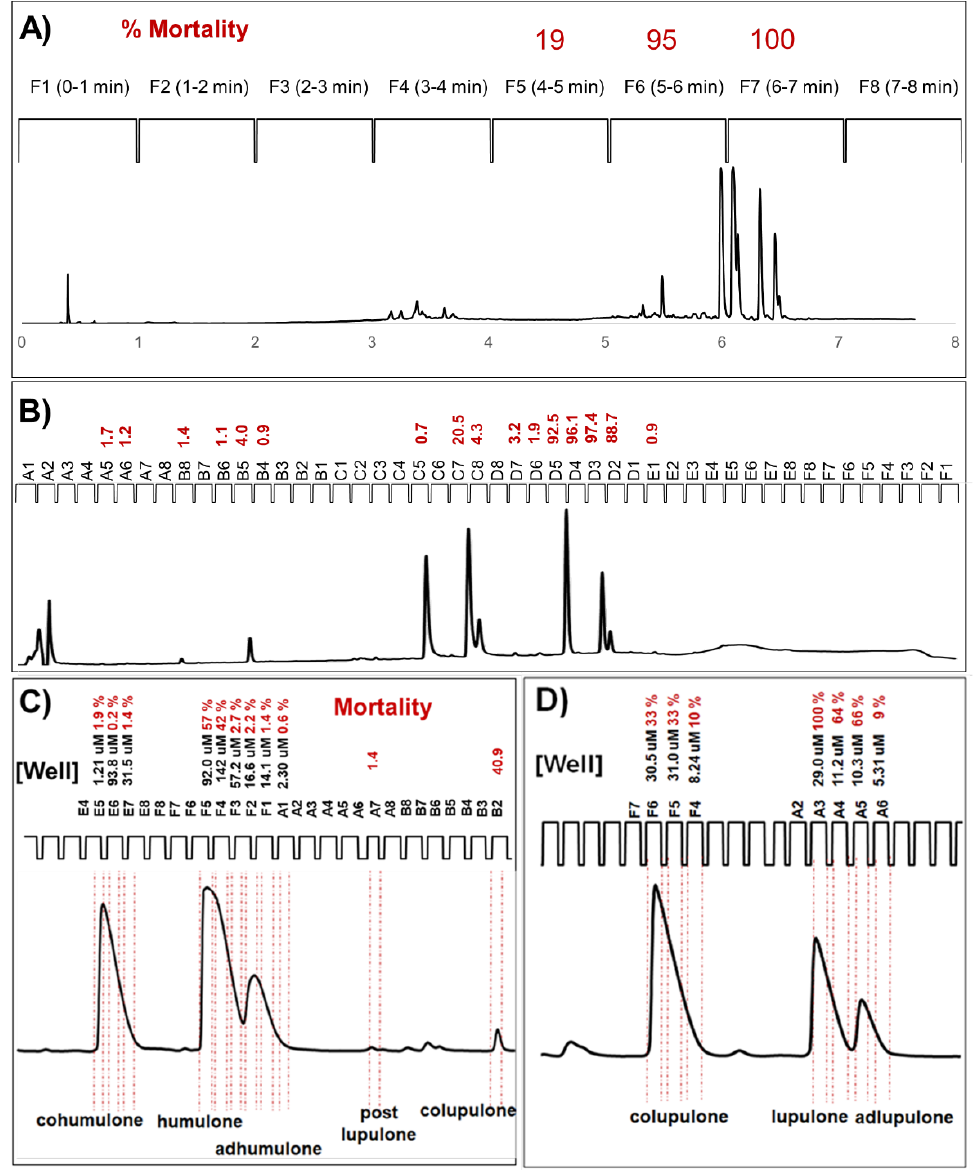
Figure 4. Representative bioassay screening data generated using UMSF technique. ( A ) Initial screening data for Humulus lupulus L. extract, with mortality assessed at 24 h post exposure using low-resolution 1 min wide retention windows; ( B) optimized, higher-resolution 10 s retention time windows; ( C ) fully optimized, 5 s wide retention time windows, showing pure alpha acid compounds in individual wells; ( D ) fully optimized, 5 s wide retention time windows showing pure beta acid compounds in individual wells. Chromatograms monitored at 250 nm.